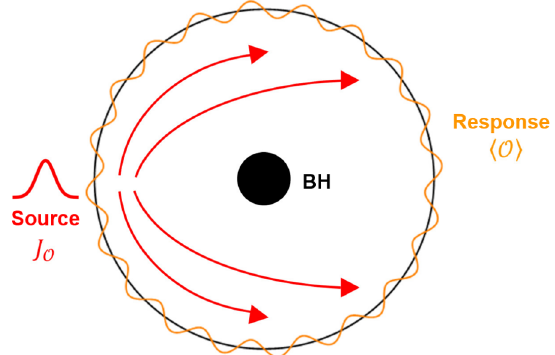
Figure 4 . The monochromatic Gaussian source J O is located at a point on the AdS boundary, and its response hOi is observed at another point on the boundary far away from the source.